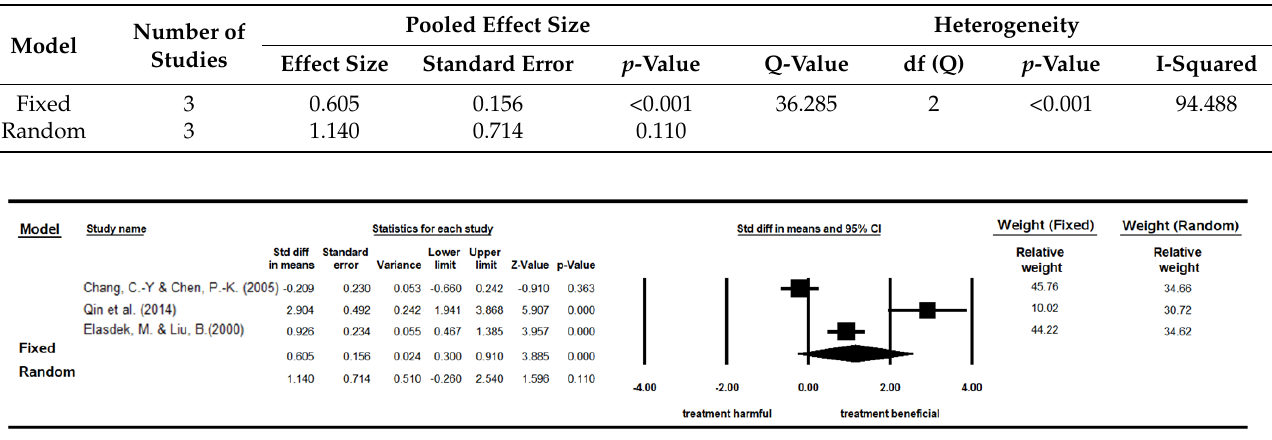
Figure 3. Forest plot of studies on the influence of indoor plants on EEG α waves [56,72,81].